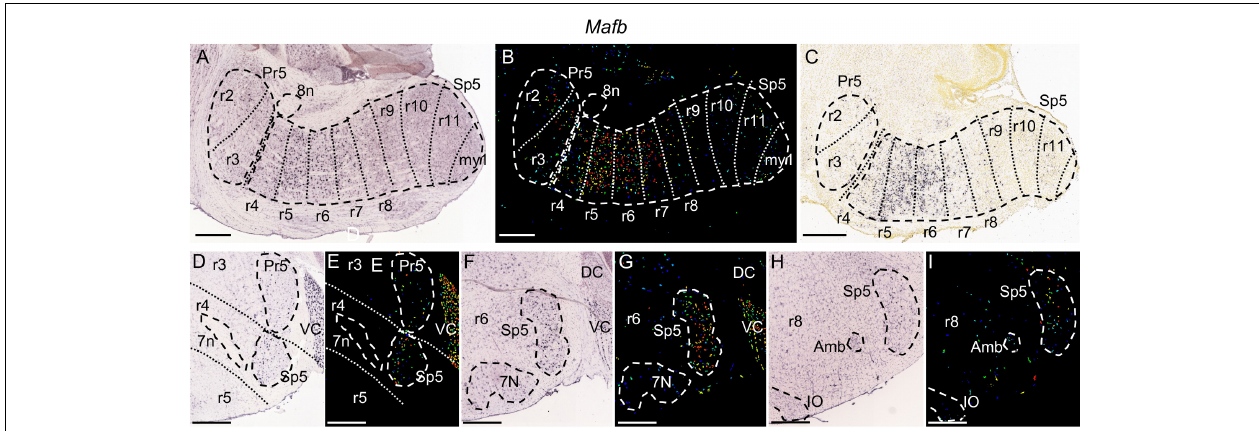
FIGURE 7 | Mafb expression. (A,B) Brightfield and color-coded images of a parasagittal section of an adult brain. Pr5 and Sp5, as well as the 8n bundle, are, respectively, encircled by dashed lines. There are sparse labeled cells along all the trigeminal column, from the r2 to the r11 trigeminal portions. The expression is strongest in the r5 and r6 portions of Sp5, showing also moderate labeling in r4 and in r7 plus r8 within Sp5. (C) Brightfield image of a parasagittal section from a P4 brain, showing the aforementioned pattern described in the adult. (D–I) Pairs of brightfield and color-coded images of coronal sections from an adult brain, respectively, at the level of r4 (D,E) , r6 (F,G) and r8 (H,I) . The principal landmarks used for their respective identification are 7n for r4, 7N for r6 and the rostralmost end of the inferior olive (IO) plus the ambiguous motor nucleus (Amb) for r8. This gene shows also significant expression in VC (D–G) . Scale bars = 500 µ